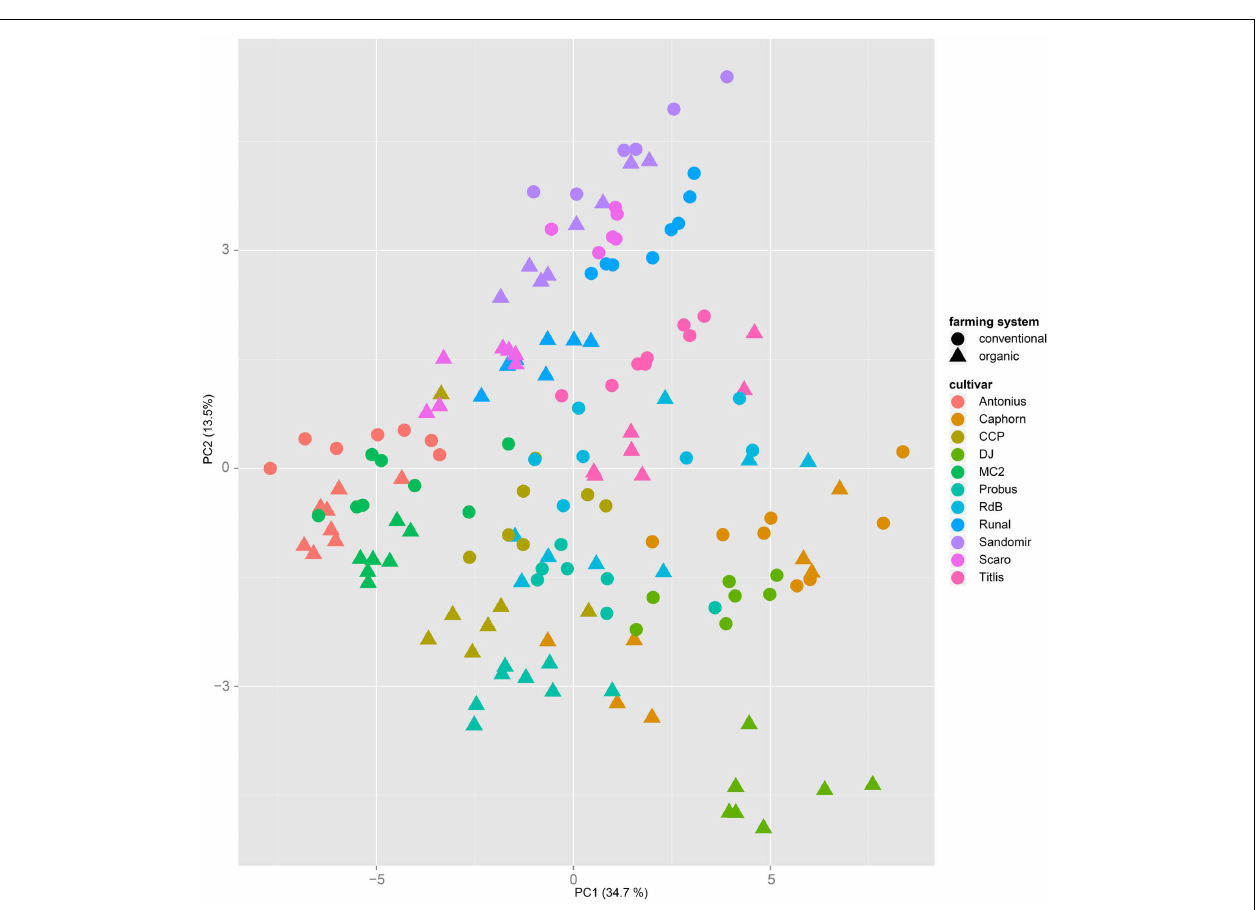
FIGURE 2 |A principal component analysis performed on a dataset from 1year only will mainly cluster samples by their cultivar, regardless of the applied farming system .This PCA is based on samples from the year